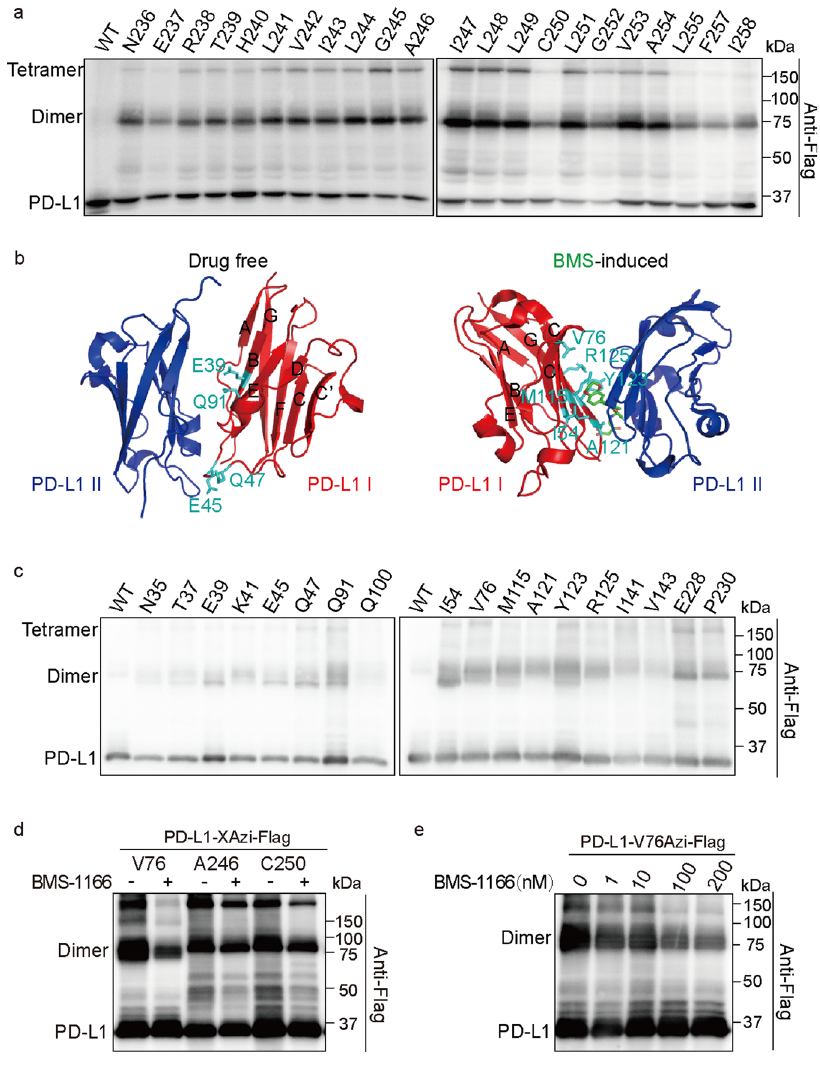
Fig. 2 The transmembrane domain and extracellular domain of PD-L1 are involved in homodimerization. a Transmembrane domain of PD-L1 is involved in its homodimerization. Residues that were replaced by Azi are indicated in the upper row. WT PD-L1 treated with UV was used as a control. HEK293T cells were irradiated with UV before being lysed. Shown are immunoblotting using anti-Flag antibodies. b Structure of drug-free and BMS- induced PD-L1 homodimer. The PDB ID is 3FN3 for drug-free PD-L1 homodimer and 5N2F for BMS-induced PD-L1 homodimer. BMS was colored green. Residues that are important for PD-L1 homodimerization were colored cyan. c Screening of residues in extracellular domain that covalent captured PD-L1 homodimer. Transfected cells expressing PD-L1-XAzi-Flag proteins were treated with UV to induce cross-linking and performed immunoblotting analysis. d , e BMS-1166 reduces Azi-mediated covalent capture of PD-L1 homodimerization dosage dependently. HEK293T cells were transiently transfected with PD-L1-Xtag-Flag and pIRE4-Azi plasmids. d Residues replaced by Azi are indicated in the upper row. 100 nM of BMS-1166 were incubated with cells for 18 h before UV treatment. e Working concentration of BMS-1166 ranged from 0 to 200 nM. All samples were treated with PNGase F to remove the